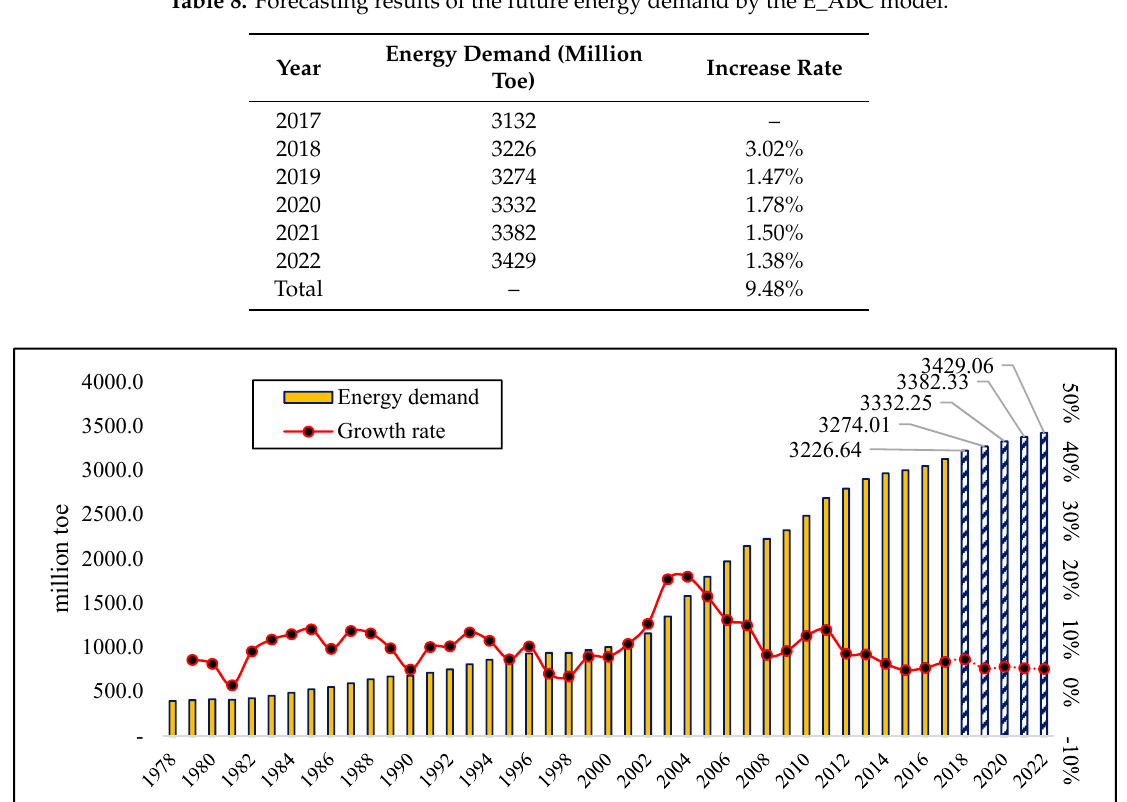
Figure 9. Forecasting results and the growth rate of the future energy demand.